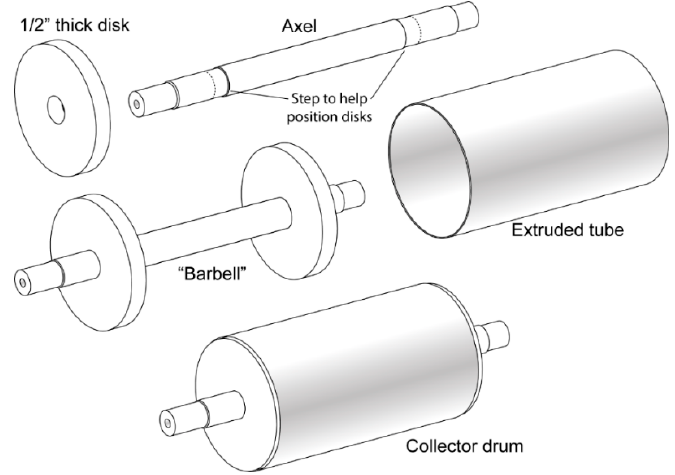
Figure A6. Schematic of the collector drum being constructed. Two ½” thick disks are placed on either side of the axel. An extruded tube is then slid over the disks. All parts were TIG-welded together.